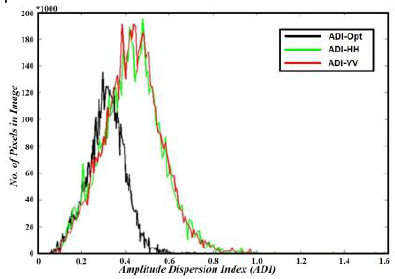
Figure 2. Histograms of ADI for HH, VV and optimum channel After the meaningful increase in density of PSCs due to ADI optimization the next step is to iteratively finalize PS pixels among PSCs using Equation (1).